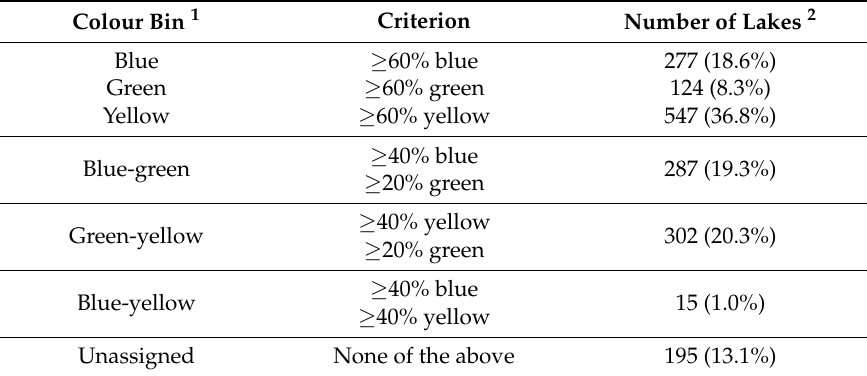
Figure 9. Geographic distribution of lakes coloured by colour bins according to Table 1 in four areas. Placement of the areas shown in maps ( a – d ) are shown in Figure 5.